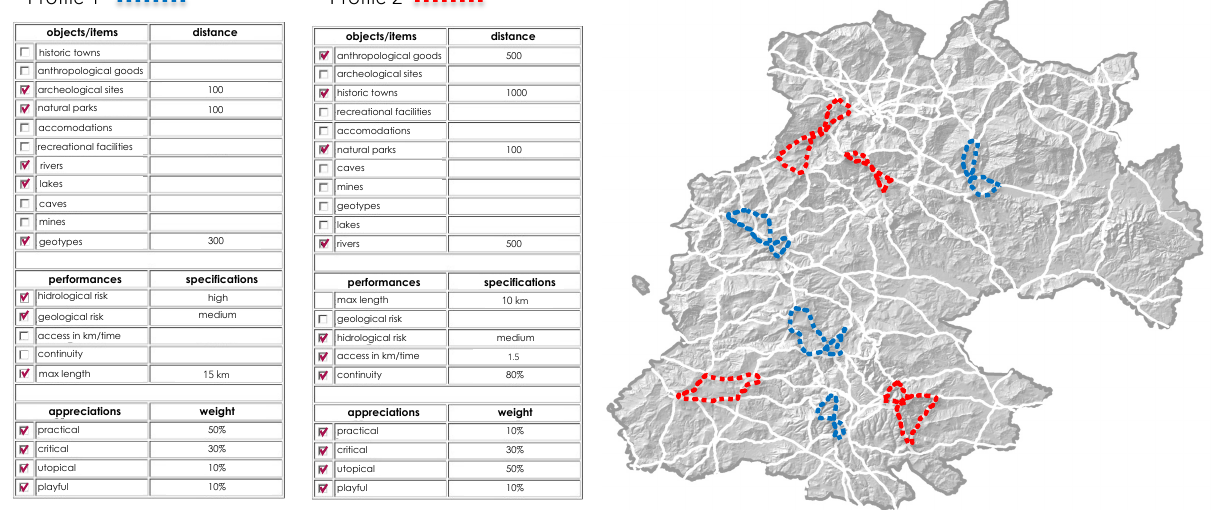
Figure 15. Comparison of the paths corresponding to the two different traveler’s